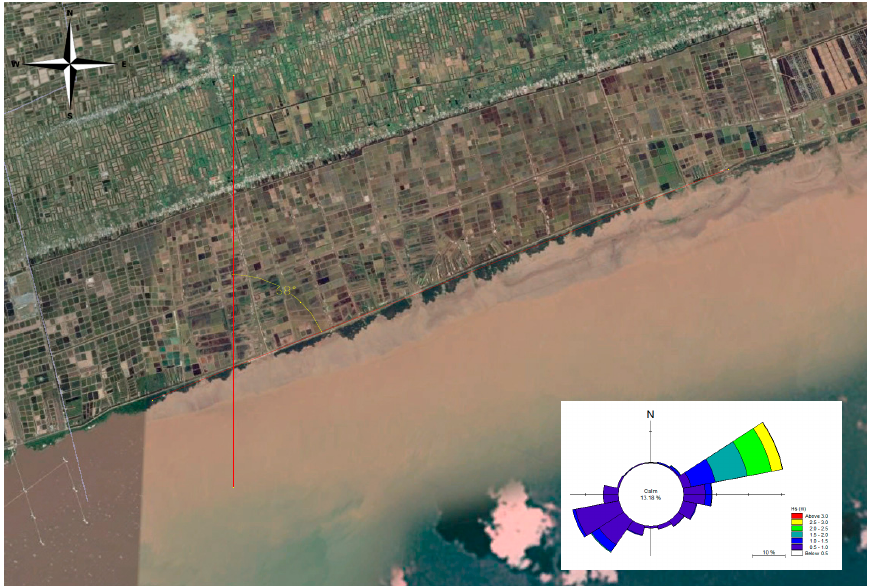
Figure 3. Deep water wave rose 30 km from the shore (MIKE 21 SW). Table 1. Design wave for the structure prototype location.